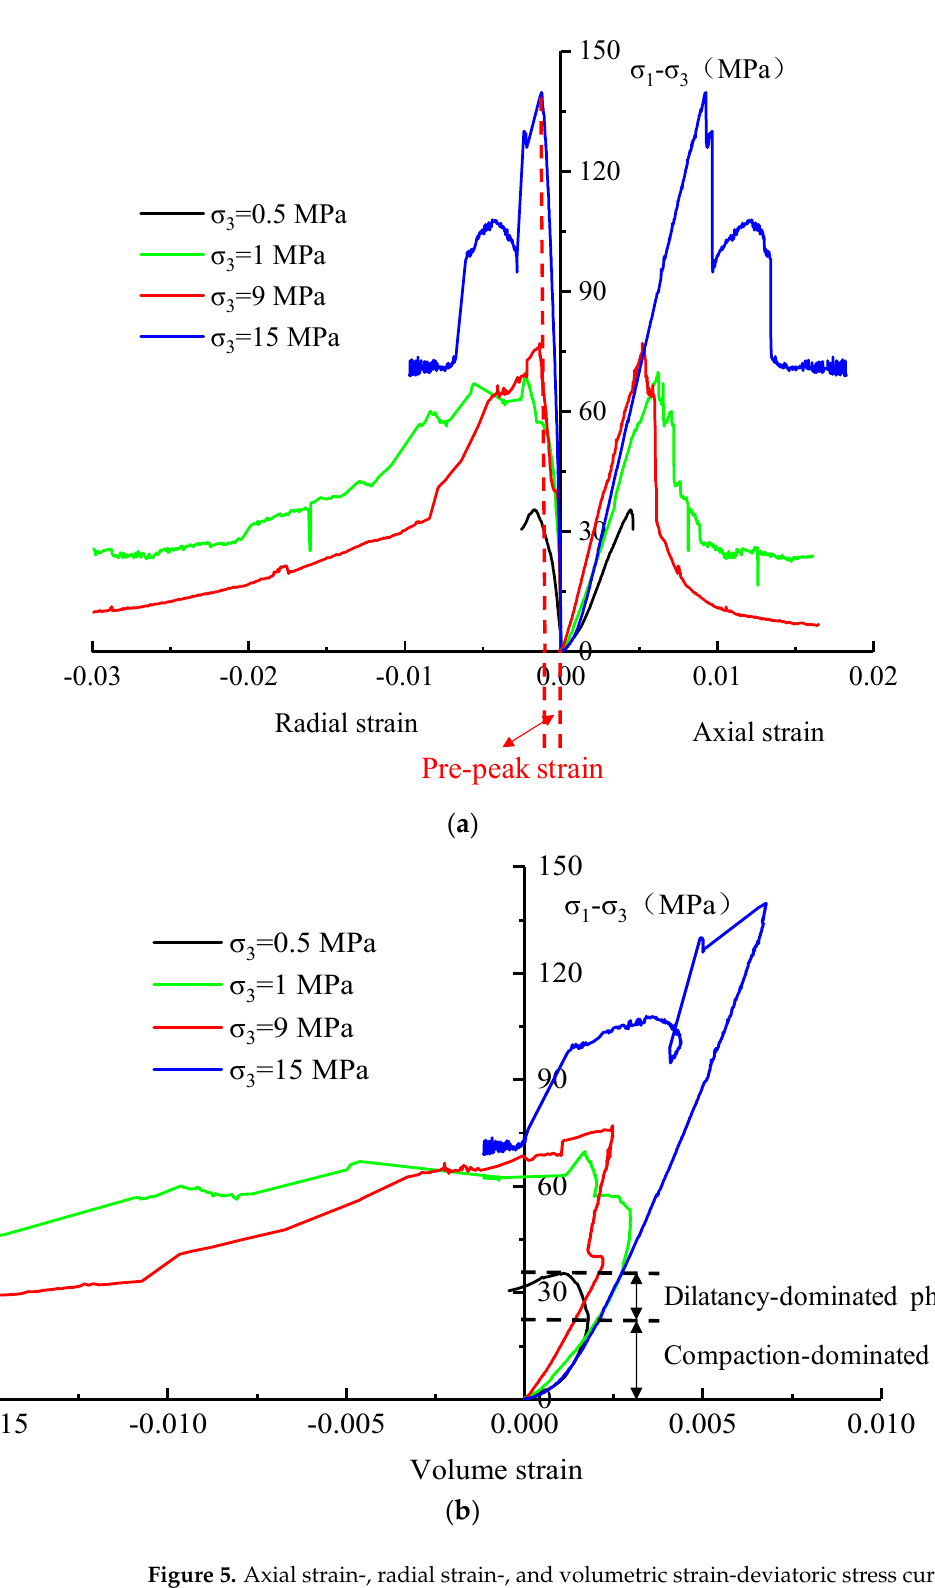
Figure 5. Axial strain-, radial strain-, and volumetric strain-deviatoric stress curves of the dolomitic limestone samples under different confining pressures.